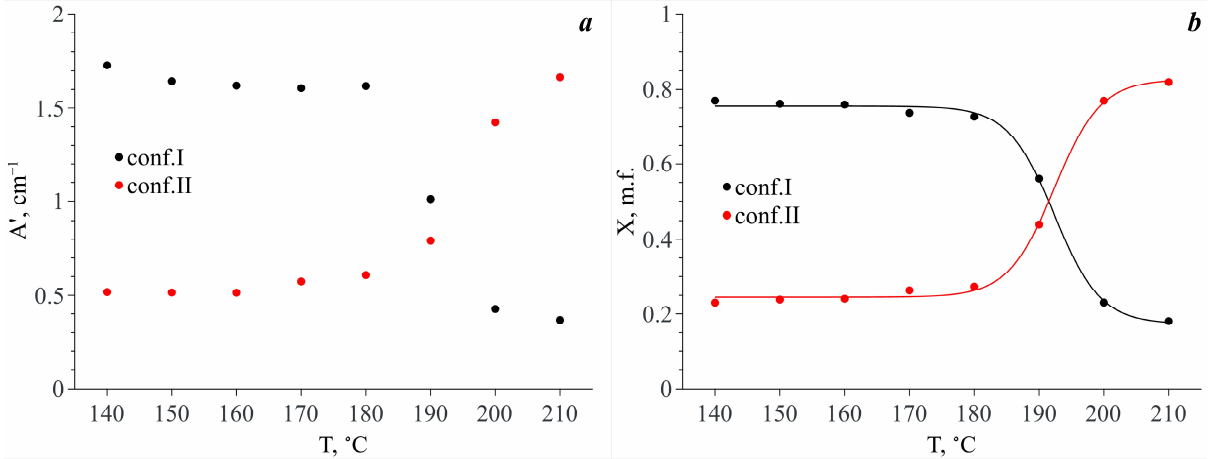
Figure 10. ( a ) Temperature dependencies of the integral intensity values summed pairwise (A ′ ) for the spectral profiles that correspond to Conf. I and Conf. II (see Figure 9); ( b ) Temperature dependences of the mole fractions (X) of these conformers calculated as X i = A (cid:48) i / ∑